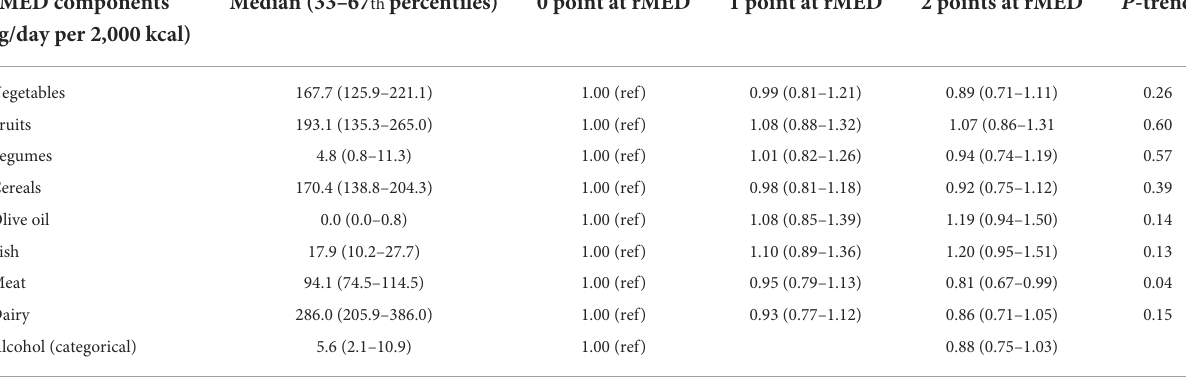
TABLE 4 Hazard ratios (95% Confidence Intervals) of the association between each component of Mediterranean diet (MD) and differentiated thyroid cancer risk in the EPIC study. rMED